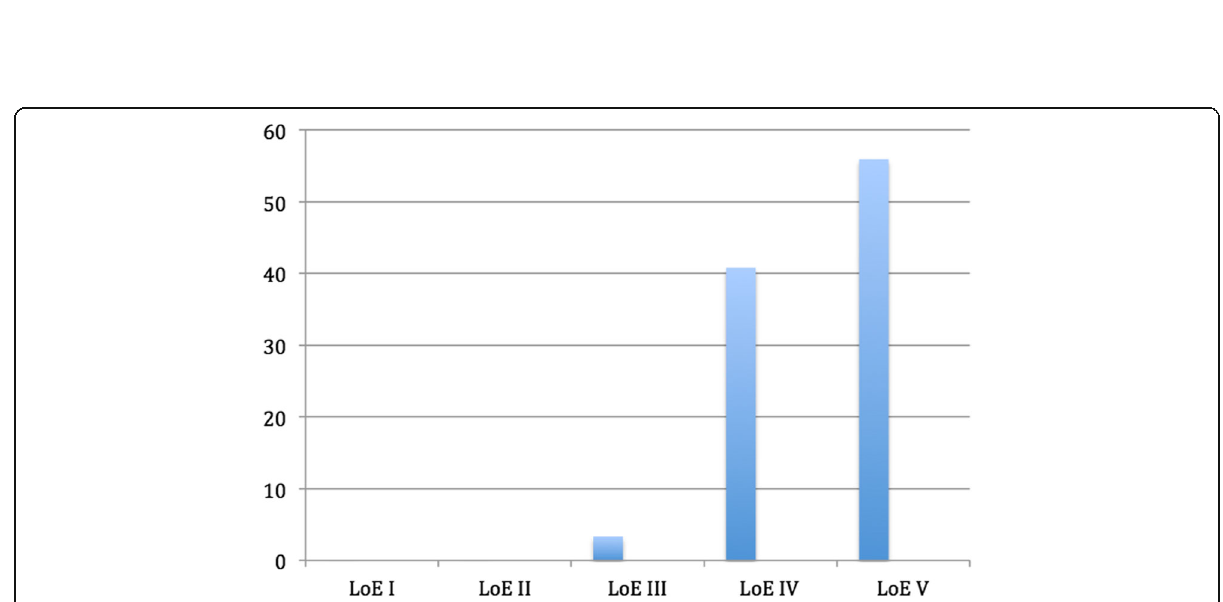
Fig. 2 Distribution (%) of the level of evidence of the included